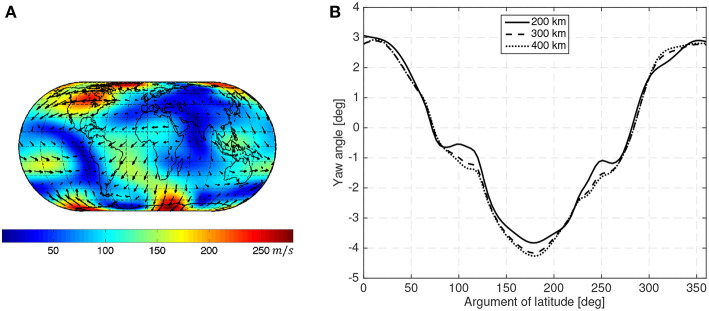
Wind pattern according to the HWM93 (Hedin et al., 1996) model at 450 km with moderate solar activity (ISO 14222, 2013) during northern hemisphere summer solstice (A) and yaw angle caused by atmospheric co-rotation and wind during a circular sun-synchronous orbit at different operational altitudes (B).